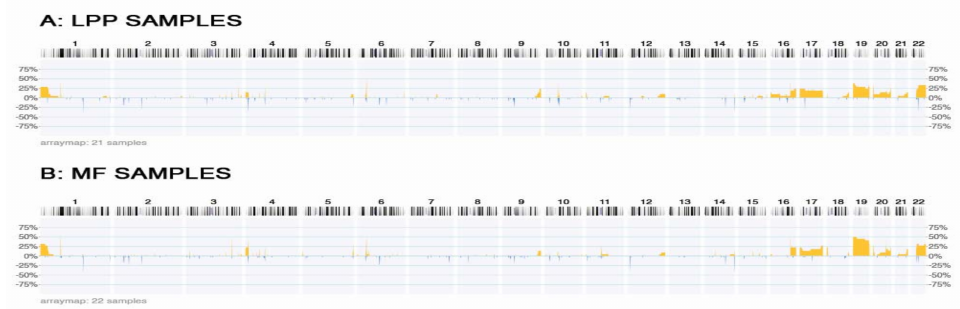
Figure 1. Frequency of genomic gains and losses in LPP (A) and MF (B). The heat map shows the frequency of gains (orange, up)/losses (blue, down), ordered from chromosome 1–22. For example, a frequency of 25% means that, in 25% of the selected cases, a variation in the copy numbers (deletions or duplications) was